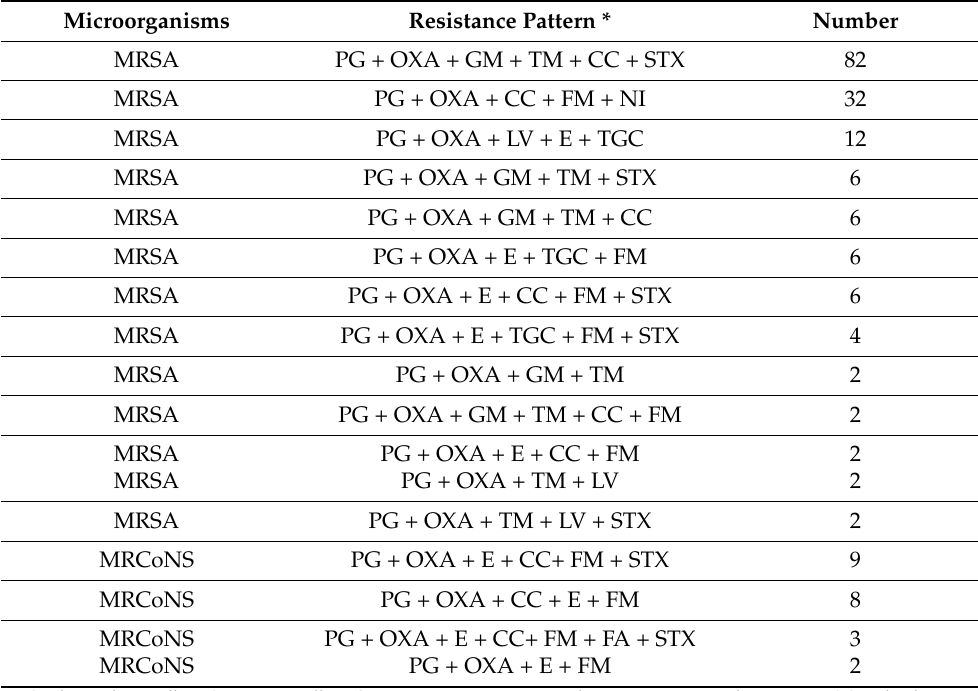
Table 3. Resistance patterns of methicillin-resistant Staphylococcus spp.